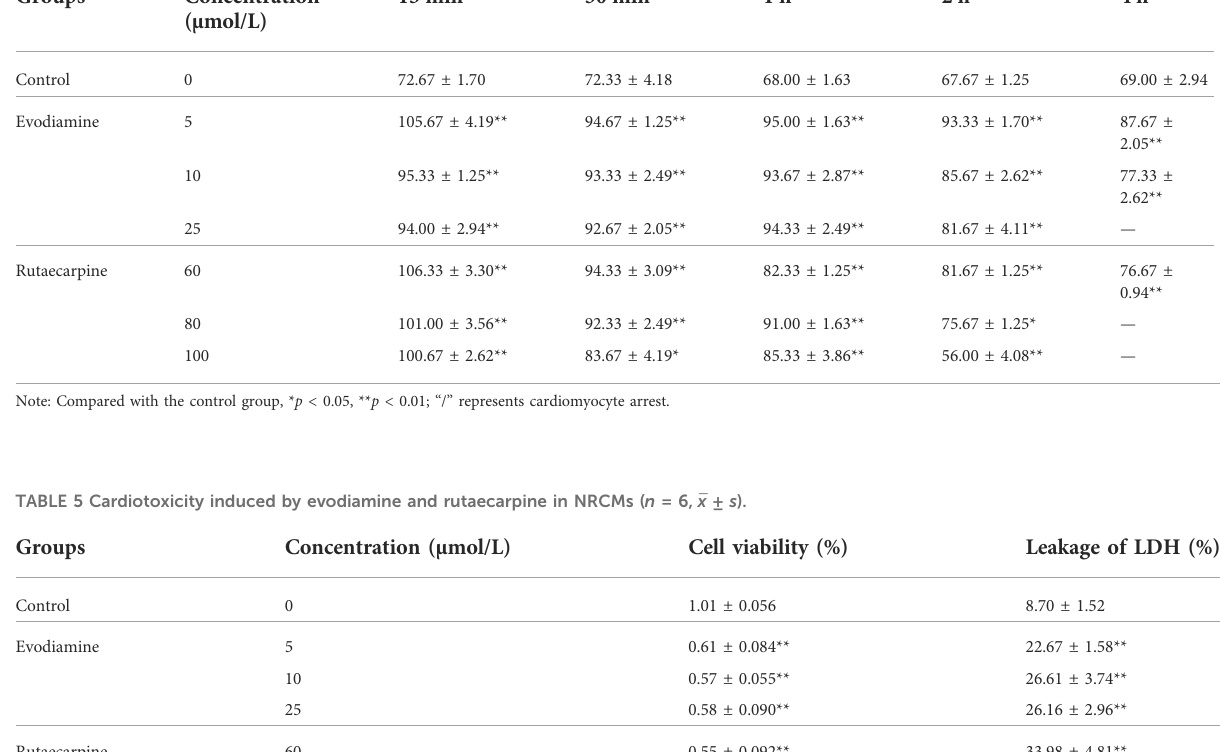
TABLE 4 Frequency of NRCM spontaneous beat of evodiamine and rutaecarpine ( n = 3, ‾ x ± s ). Groups